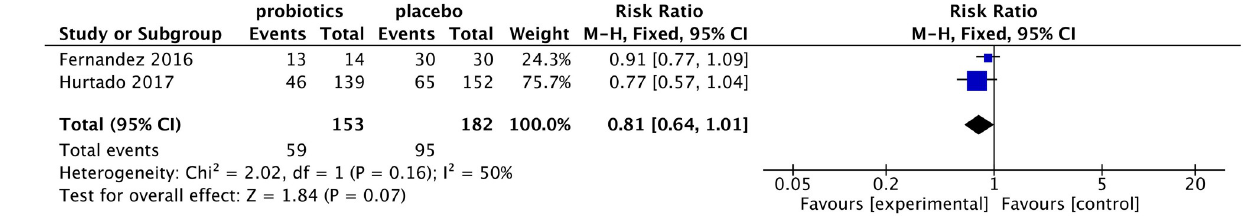
Fig 5. Forest plot of the incidence of breast pain.